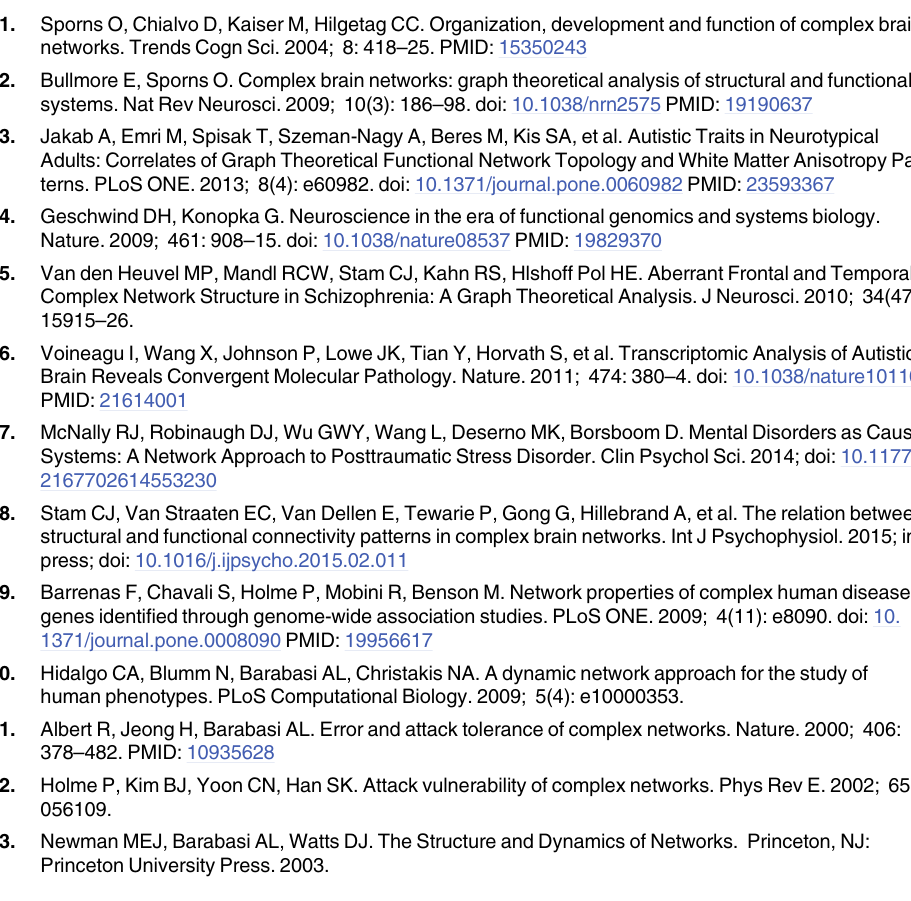
S1 Table. CHIDS Sample Variable Table.